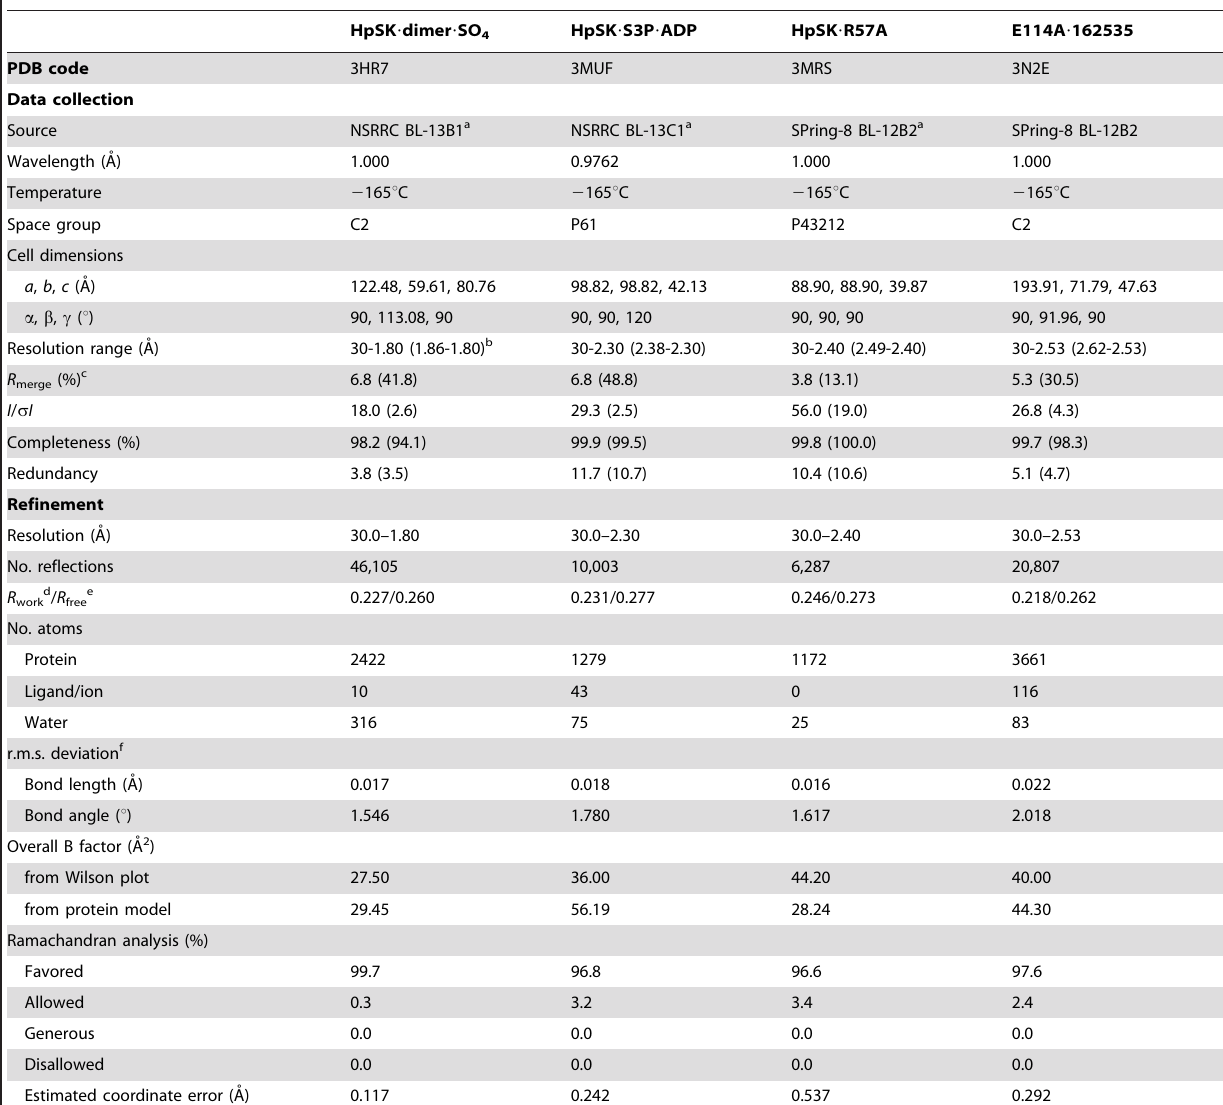
Table 2. X-ray data collection and refinement